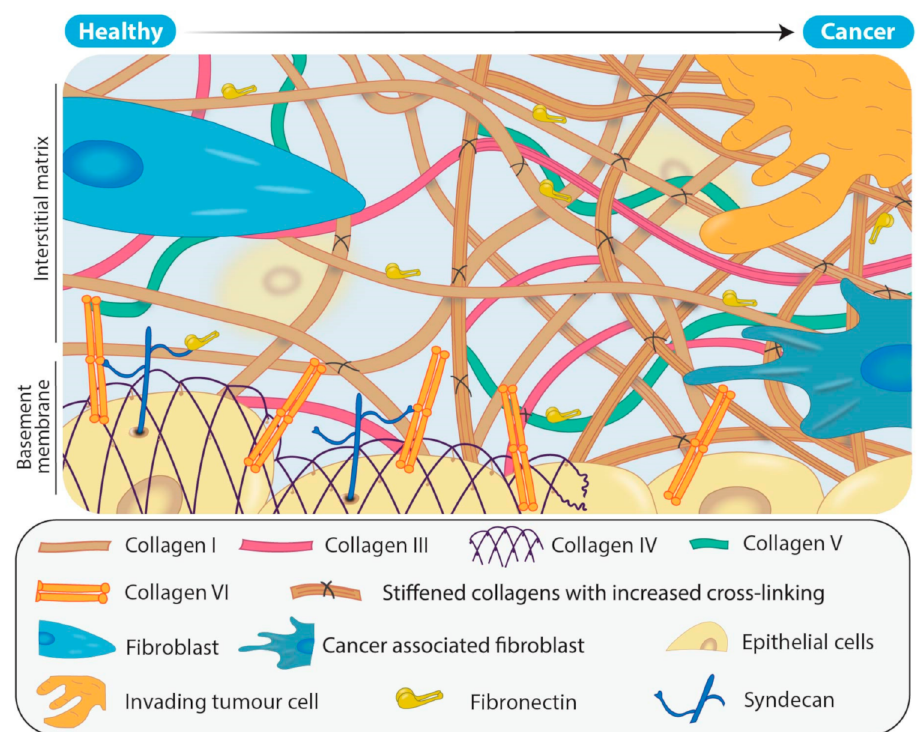
Figure 2. Remodeling of the extracellular matrix (ECM) in solid tumours. In healthy tissue, the ECM has a structured basement membrane consisting primarily of collagens IV and VI as well as a scaffolding arrangement of fibrillar collagens that are predominantly secreted by the fibroblasts. In comparison, solid tumours typically consist of more densely packed, aberrantly cross-linked fibrillar collagens resulting from the recruitment and activation of CAFs. As the level of deposition of fibrillar collagens such as collagens I, III and V increases in the tumour ECM, so too does LOX family mediated collagen cross-linking. In addition, tumour ECM results in a breakdown of the structure of the normal basement